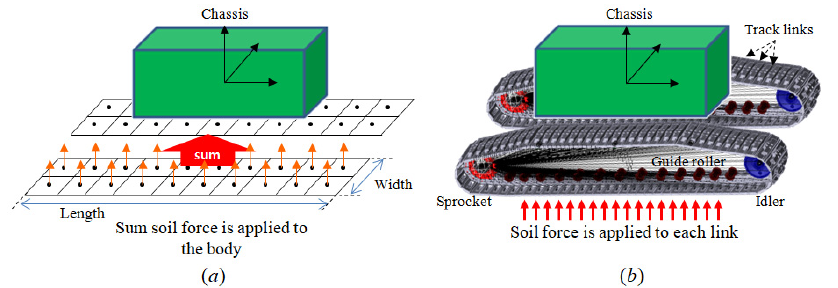
Figure 12. Mining robot models: ( a ) concept of a single-body track model, ( b ) concept of a multibody track model. track